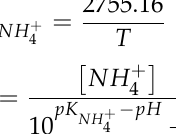
Table 2. Literature of examples of waste streams for nitrogen recovery.